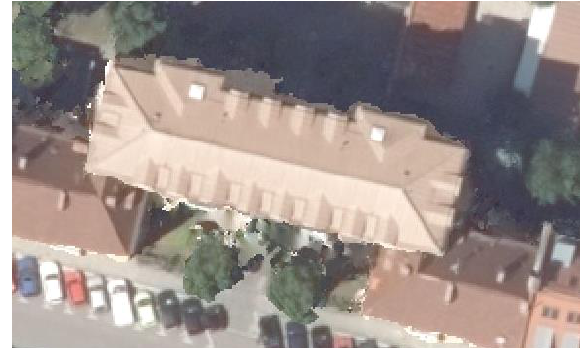
Figure 21. TrueDOP presentation of a building object with fringes at the object edges